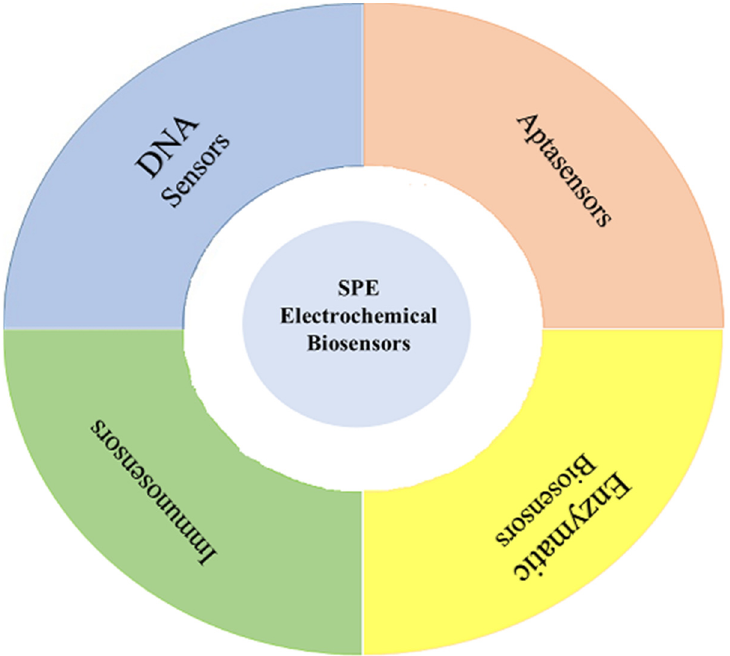
Figure 1. Classification of SPE electrochemical biosensors.